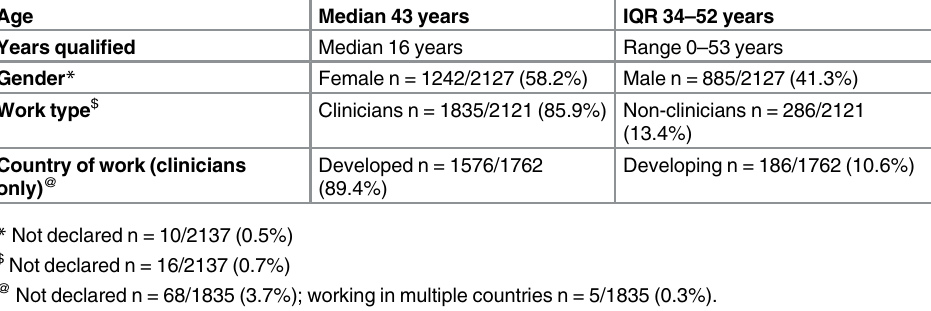
Table 1. General respondent demographic